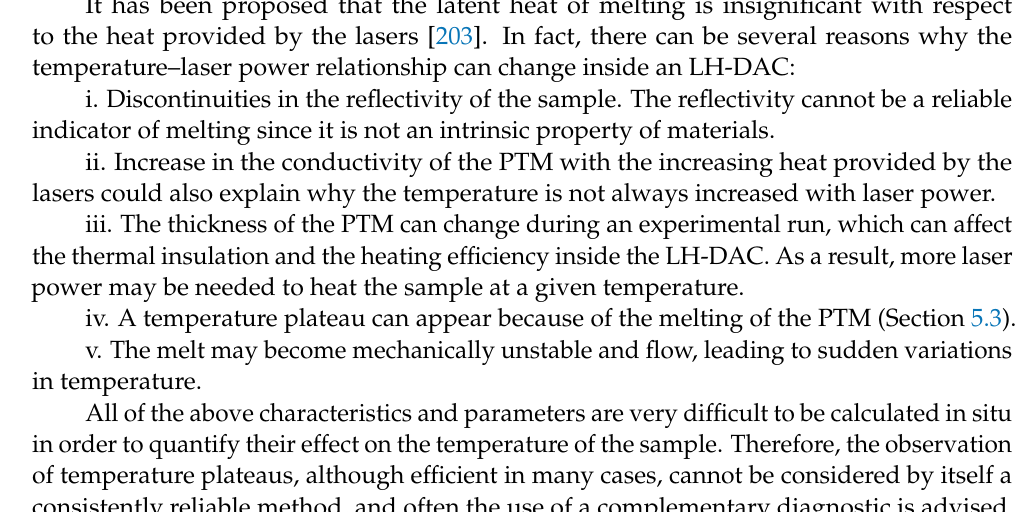
Figure 6. Comparison of temperature versus laser power curves in different samples and different heating runs: ( a ) Zr at 49 GPa [37], ( b ) Zr at 80 GPa [37], ( c ) Ni at 46 GPa [84], ( d ) Ti at 42 GPa [36]. In all of these works, the melting was determined by XRD liquid diffuse scattering (Section 4.2), and the melting temperature found at the given pressure is shown by the straight pink line.